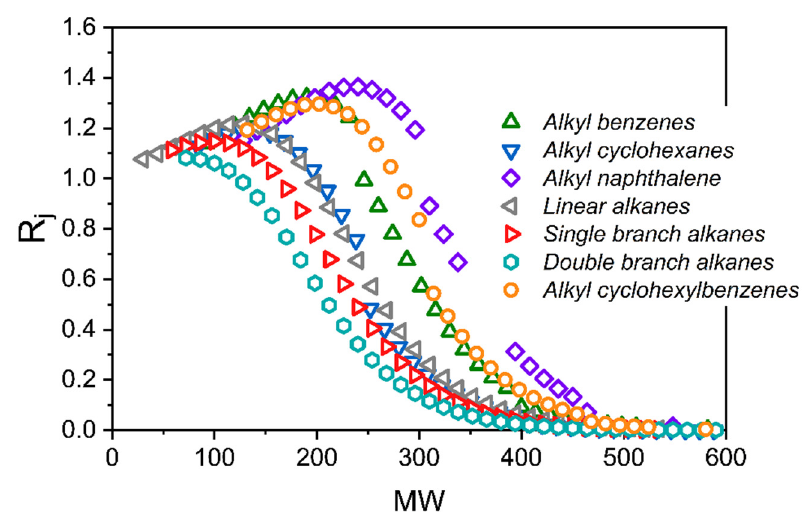
Figure 8. Model predicted separation coefficients versus molecular weight for several molecular classes at 130 °C and 55 bar.